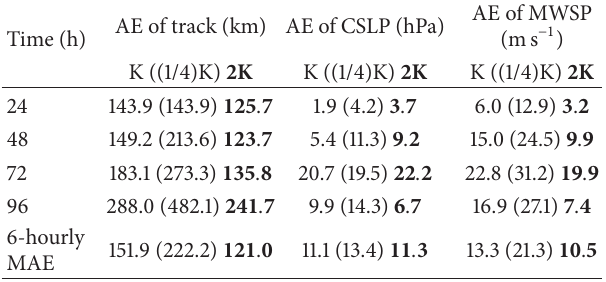
Table 3: Case 2-Rammasun: AE and MAE of track, CSLP, and MWSP.